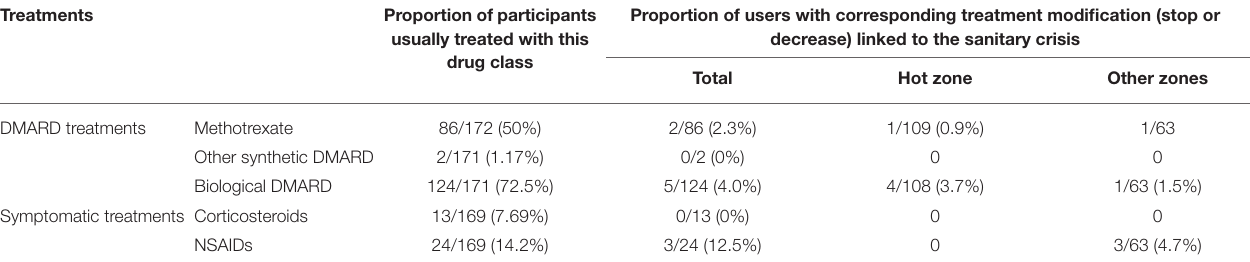
TABLE 2 | Treatment modification in the JIA